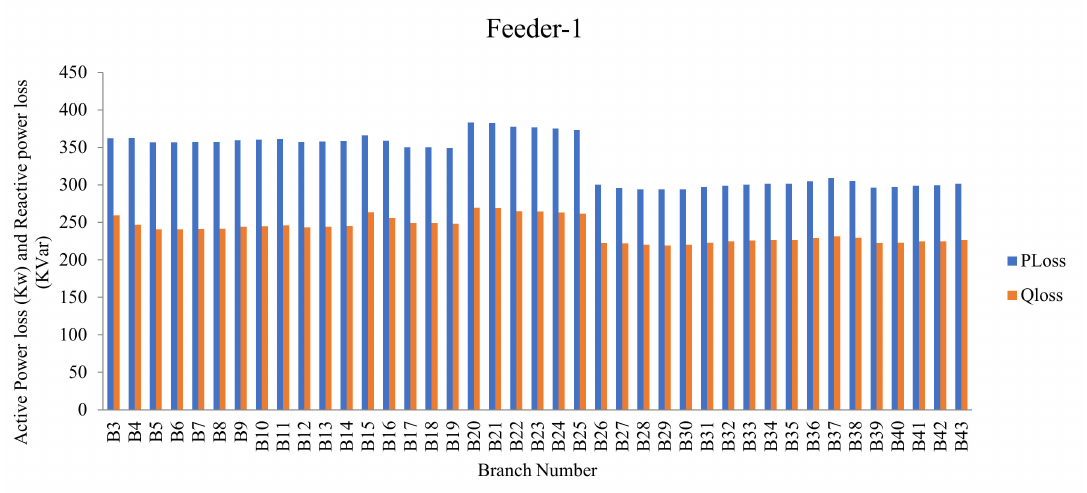
Figure 8. Active and reactive power loss when DG is integrated into Addis North feeder-1.